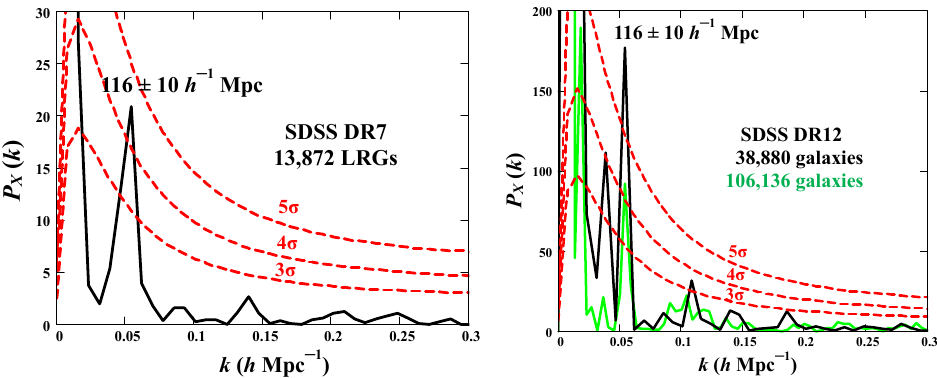
Figure 7. ( Left panel ): Same as the right panels in Figure 3 but with the inclusion of the Hann function (14) in the calculations of the window Fourier spectra (using the same DR7-Full data). ( Right panel ): Same as in the right panel of Figure 3 but using the data of SDSS DR12 related to the same six sectors in the sky. The green curve is the 1D power spectrum calculated for the extended interval 464 ≤ X ≤ 1844 h − 1 Mpc ( 0.16 ≤ z ≤ 0.72 ) of projections of the Cartesian galaxy coordinates on the axis X 0 ( α 0 = 176 ◦ and δ 0 = 27 ◦ , see Table 1) corresponding to the maximum peak at k max = 0.054 h Mpc − 1 . The black curve is also a 1D power spectrum with the same k max but calculated for the smaller interval 464 ≤ X ≤ 1274 h − 1 Mpc ( 0.16 ≤ z ≤ 0.47 )) used in Figures 3 and 4; in this case, X 0 is oriented along direction α 0 = 175 ◦ and δ 0 = 25 ◦ ; the sample sizes for both sets of data are also shown. The significance levels 3 σ , 4 σ and 5 σ (dashed lines ) are calculated for the extended sample of SDSS DR12 (see Section